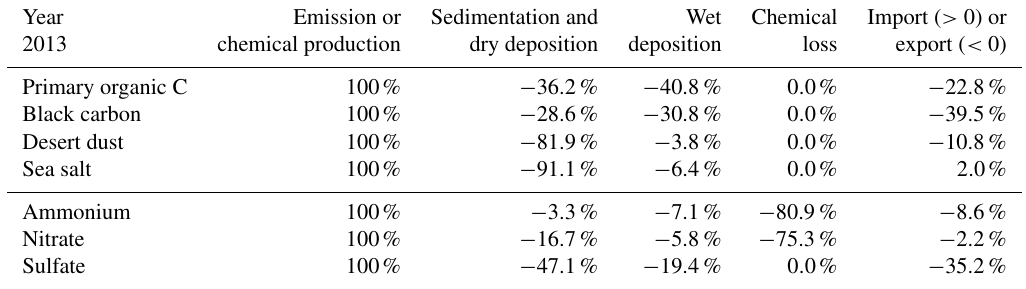
Table 12. Annual budget of the total mass of aerosols for the year 2012 as a percentage of the emission or the production. Year Emission or Sedimentation and Wet Chemical Import ( > 0) or 2012 chemical production dry deposition deposition loss export ( < 0) Primary organic C 100% Black carbon Desert dust Sea salt Nitrate